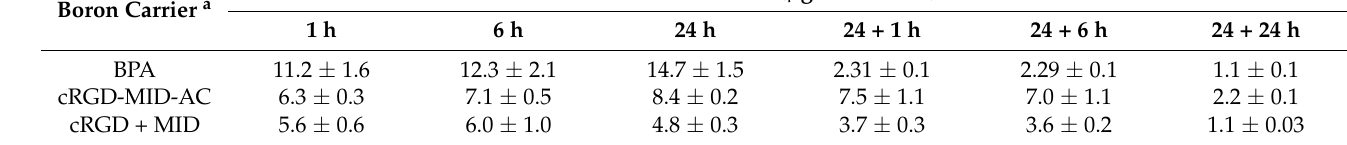
Table A2. Cellular uptake of boron in C6 glioma cells incubated with 10 µ g B/mL of each boron carrier.